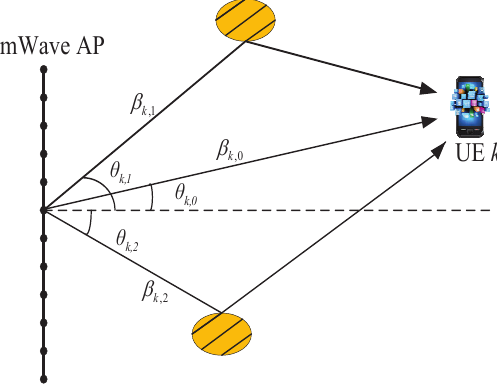
Figure 2. The Saleh-Valenzuela channel model ( L =